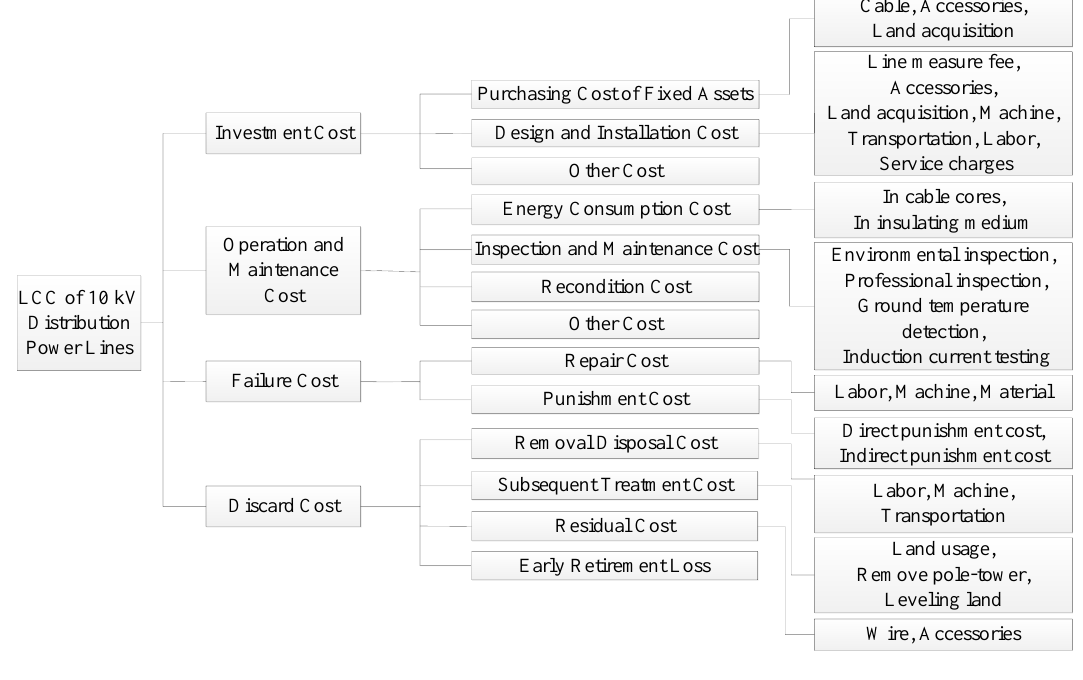
Figure 1. Basic life cycle cost (LCC)